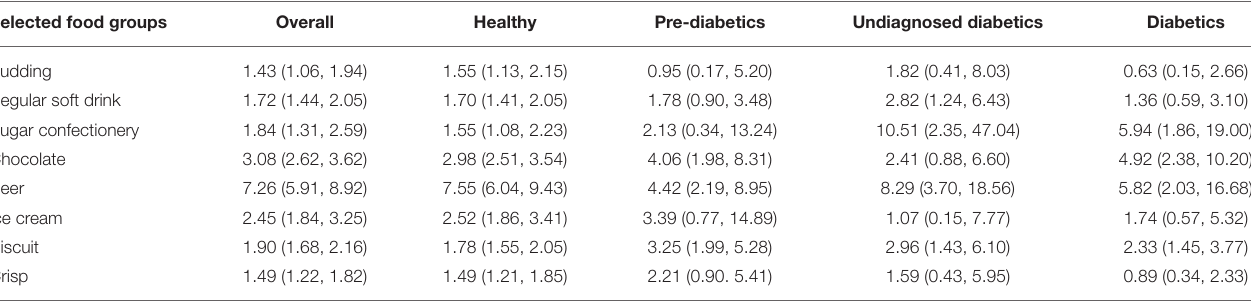
TABLE 2 | Odds ratio (99% CI) for food groups eaten at night (8 p.m. - 6 a.m.) vs. earlier time in the day, in the overall sample and according to different diabetes status, NDNS RP 2008-2017. Selected food groups Overall Healthy Pre-diabetics Undiagnosed diabetics